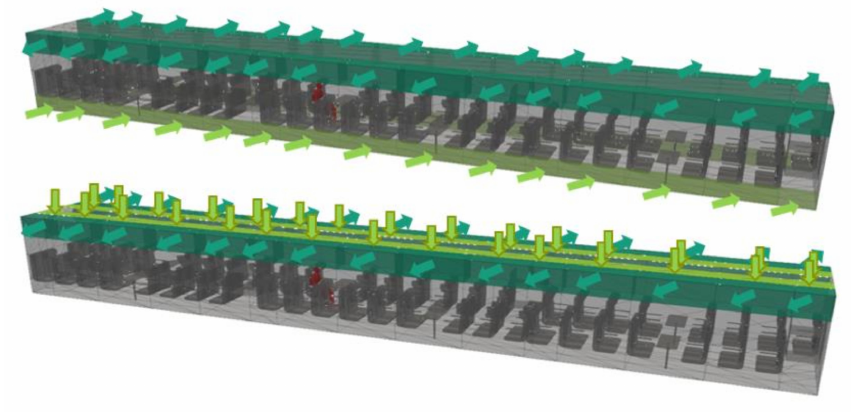
Figure 5. Zonal model of the ICE 4 with sources and sinks for heating ( top ) and cooling ( bottom ) mode: light green arrows, supply air; dark green arrows, exhaust air; red-marked person, emitter.